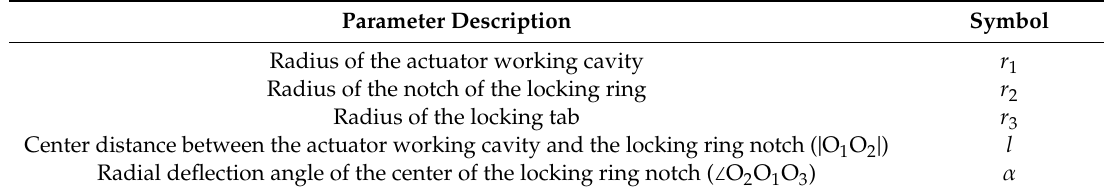
Table 2. The intermediate parameters in the calculation process.